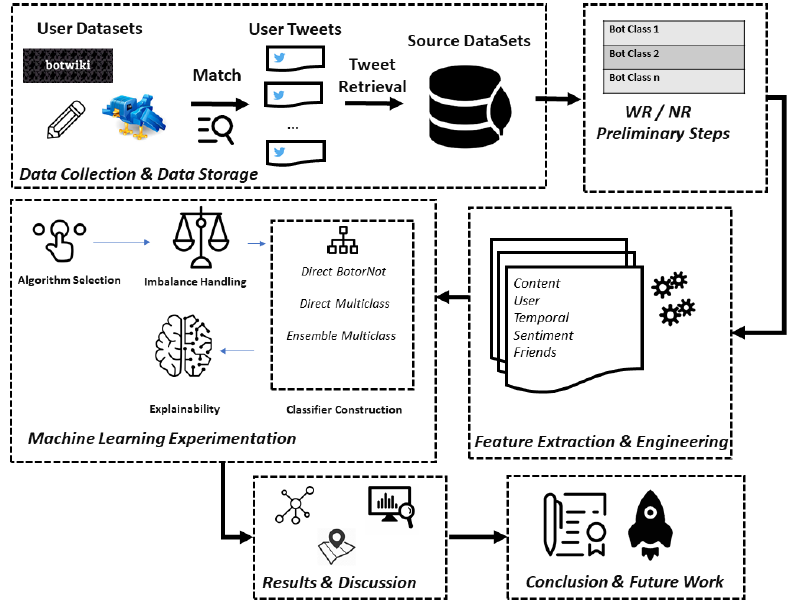
Figure 1. Outline of the proposed framework architecture. The data collection and analysis phase is discussed in Section 3, while the ML and feature engineering approach is further discussed in Section